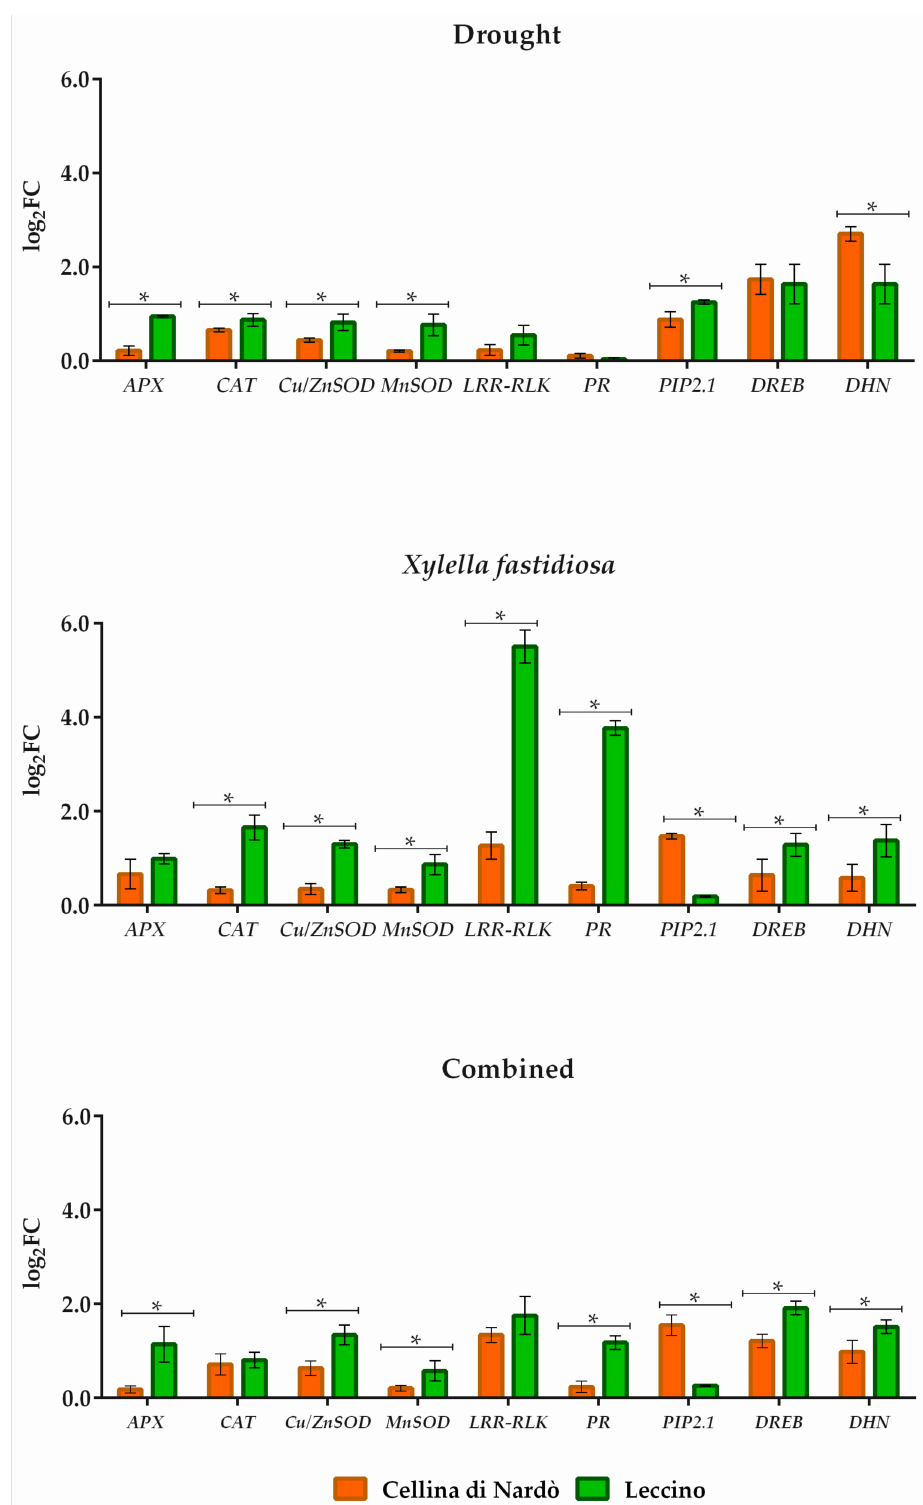
Figure 4. Comparison of Cellina di Nard ò and Leccino cultivars in gene expression level subjected to drought, pathogen Xylella fastidiosa and combination of both stresses expressed as log 2 fold change (log 2 FC). The genes related to oxidative stress are: Superoxide dismutase ( Cu / Zn SOD and MnSOD ), Catalase ( CAT ), Ascorbate Peroxidase ( APX ), the genes related to pathogen stress are: Leucine Rich Repeats ( LRR-RLK ) and Pathogenesis-Related ( PR ) and the gene related to drought responses are: Dehydrin ( DHN ). The statistical analysis was carried out using multiple t-tests (FDR =